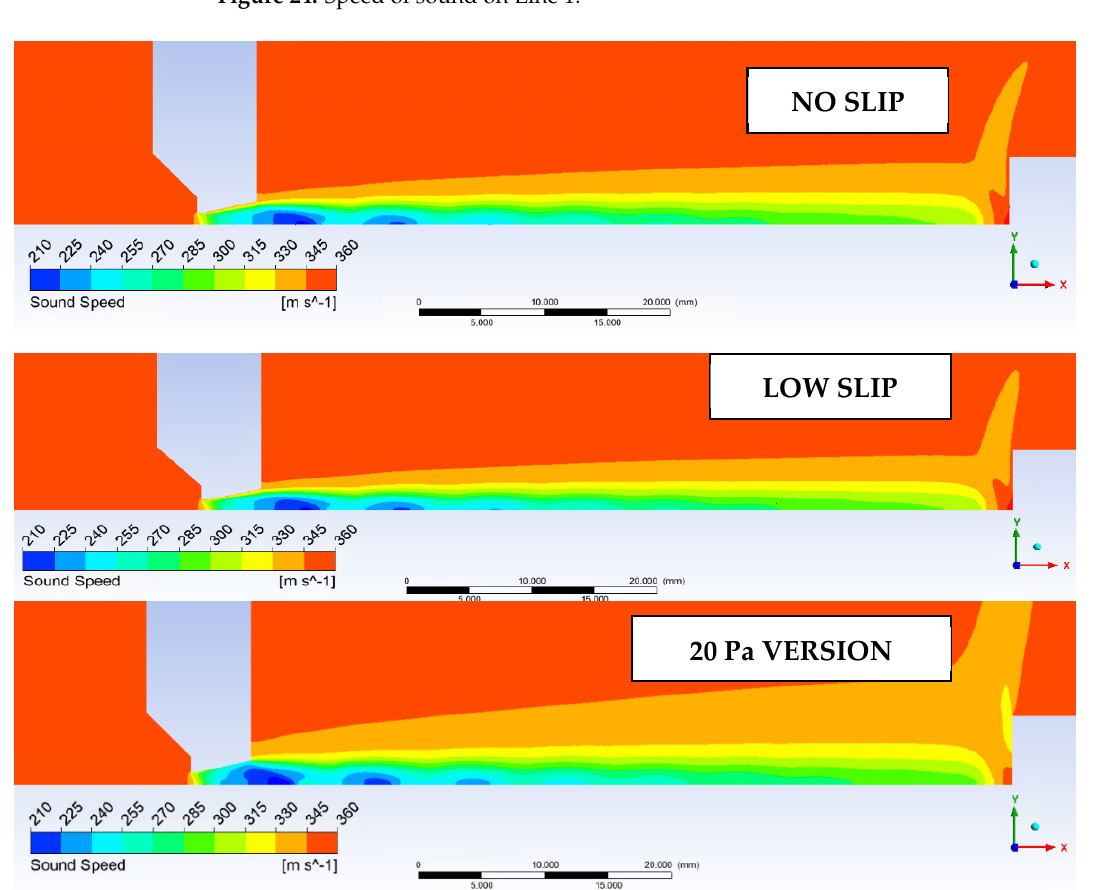
Figure 25. Distribution of the speed of sound in the experimental chamber.